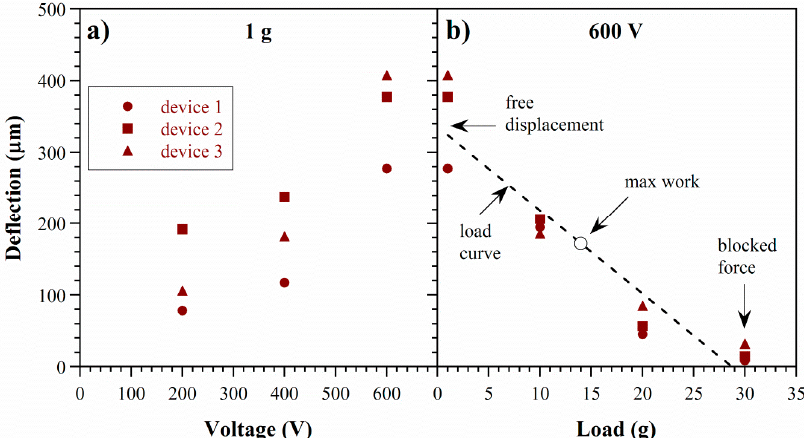
Figure 7. Membrane deflection in response to turning the voltage on and off. Error bars indicating the standard deviation of three runs at each voltage on the same device are smaller than the size of the data point marker. ( a ) Membrane deflection versus voltage under a 1 g load; ( b ) Load curve for the same devices at 600 V as the force on the membrane was increased. The dashed line is a linear curve fit to the average of the three devices.